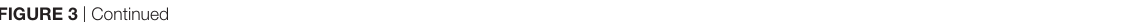
transplantation (BMT), the percentages of donor T cells in spleen were analyzed by FACS (a) . Ex vivo mixed lymphocyte reaction (MLR) was performed by coculturing splenocytes from transplanted recipients 14 days after BMT with irradiated splenocytes from BALB/c mice. Cell proliferation was evaluated by 3 H-TdR (B) . CD69 expression on CD4 + and CD8 + T cells of recipients mice 14 days after BMT was examined by FACS (c) . Purified CD3 + T cells were activated by anti-CD3/ CD28 in vitro and treated with DMF. The activation markers CD69, CD44, CD25, and costimulatory molecule PD-1 levels were analyzed 24 h after treatment (D) . IFN- γ production by CD4 + and CD8 + T cells of recipients mice 14 days after BMT was examined by Intracellular staining (e) . Serum levels of proinflammatory cytokines IL-6, IFN- γ , and TNF- α were examined by ELISA (F) . Purified CD3 + T were activated by anti-CD3/CD28 in vitro and treated with DMF for 12 h, reactive oxygen species (ROS) levels were examined by Reactive Oxygen Species Assay Kit (g) . The Nrf2, keap 1, and antioxidant defense enzymes HO-1 and GST- α 1 mRNA expressions in the spleen were examined by qRT-PCR 14 days after BMT (h) . (i) CD3 + T cells were isolated from spleen of C57BL/6 mice and activated by plate bound anti-CD3 (5 µg/ml) and anti-CD28 (1 µg/ml) in the presence of DMF or DMSO for 3 h. Nrf2 nuclear translocation was exmianed by